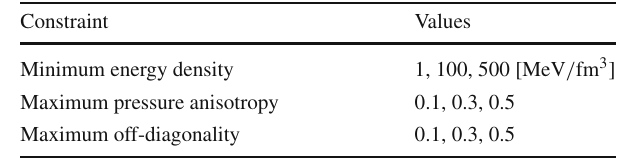
Table 2 Bins used in the 2D histograms of pressure anisotropy, off- diagonality and energy density Quantity Min Max Bins Energy density [GeV/fm 3 ] 0.01